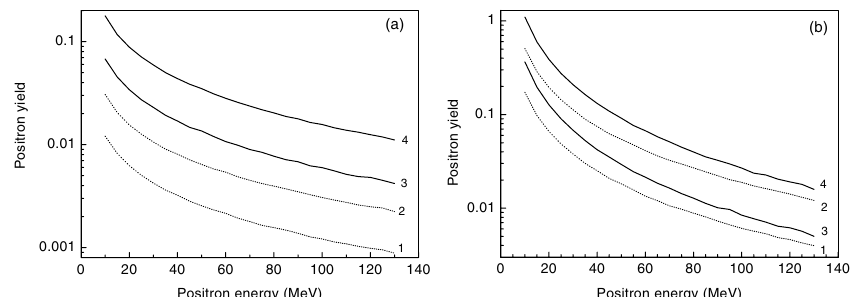
FIG. 4. Positron yield depending on energy at L (cid:16) 2 : 2 mm (a) and L (cid:16) 9 : 0 mm (b) for (cid:16) 2 : 5 MeV =c (curves 1 and 3) and for p max p max ? represent the yield from crystal and dotted curves from amorphous